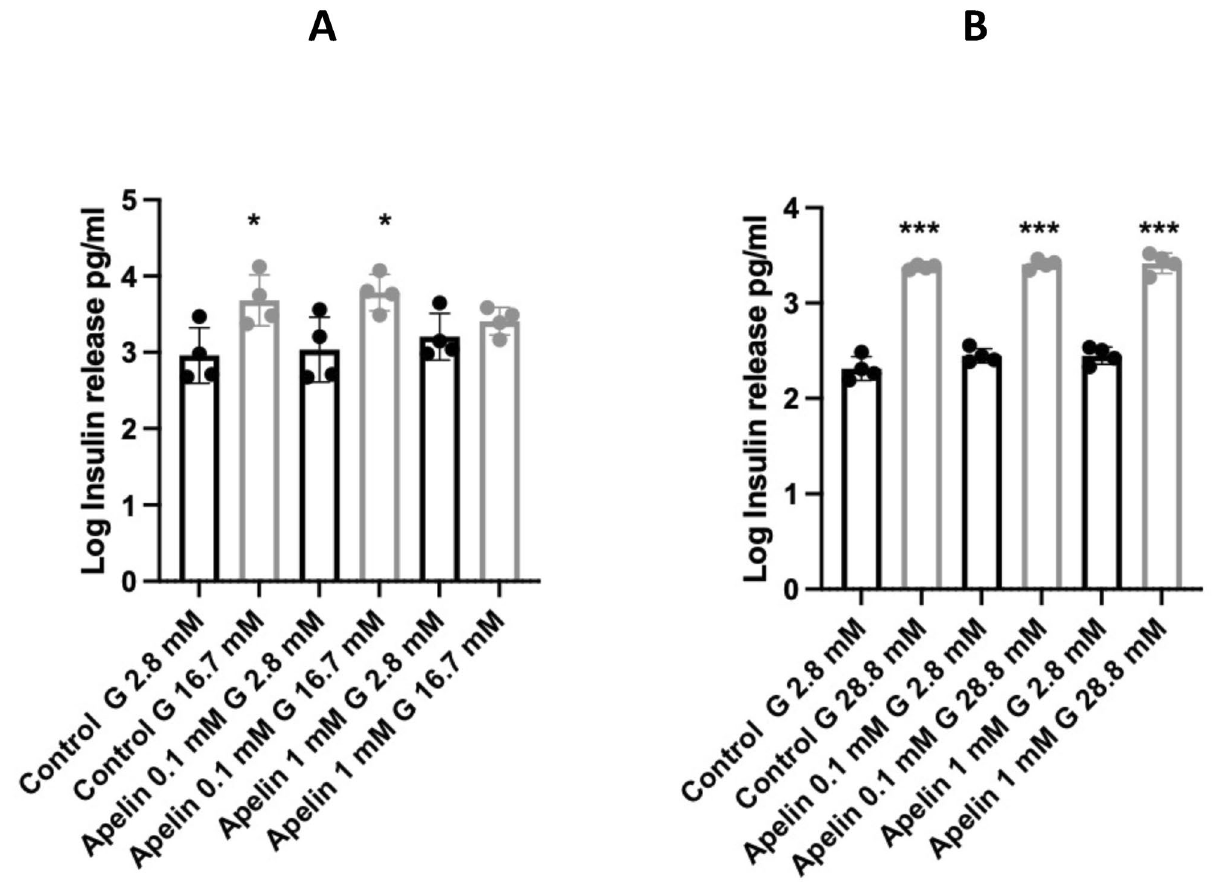
Figure 6. Insulin release (log pg/ml) from ( A ) isolated neonatal mouse islets and ( B ) INS1E cells in the presence of basal glucose (2.8 mM, black bars) or a stimulating concentration (16.7 mM glucose for islets or 28.8 mM for INS1E cells; grey bars), with or without Apelin at 0.1 mM or 1 mM concentrations. Values represent mean ± SEM (n = 4). *p < 0.05, ***p < 0.001 vs. 2.8 mM